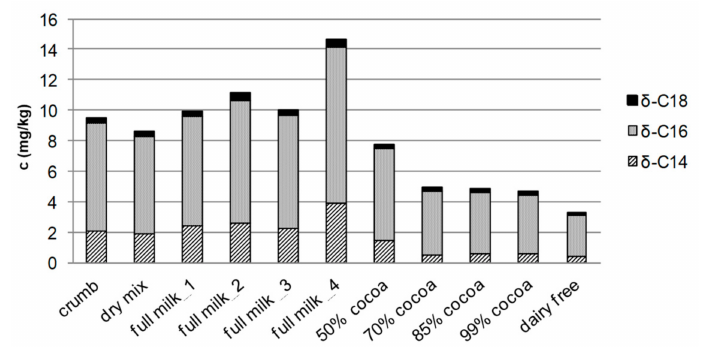
Figure 7. Concentrations of δ -tetra- ( δ -C14), δ -hexa- ( δ -C16), and δ -octadecalactone ( δ -C18) in crumb chocolate, dry mix chocolate (without crumb), four milk chocolate samples (full milk 1–4), and four dairy-free chocolate samples with various contents of cocoa (i.e., 70/85/99%, dairy-free) in fraction Ia (n-pentane extractables without triglycerides). Concentrations determined by means of LC–MS/MS (SD <